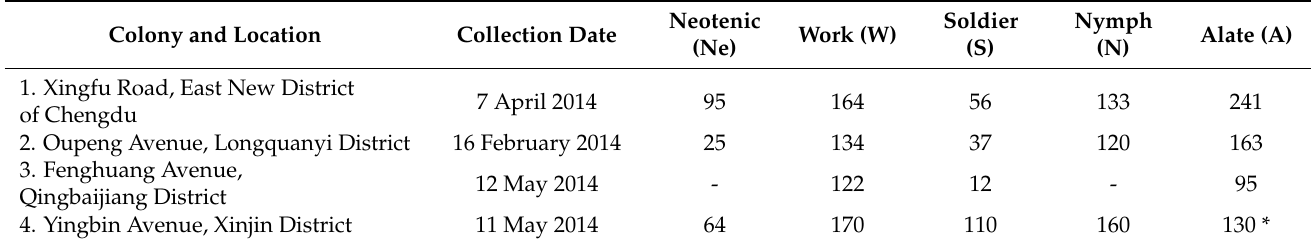
Table 2. The information of R. chinensis wild colonies and the collected number of different castes during